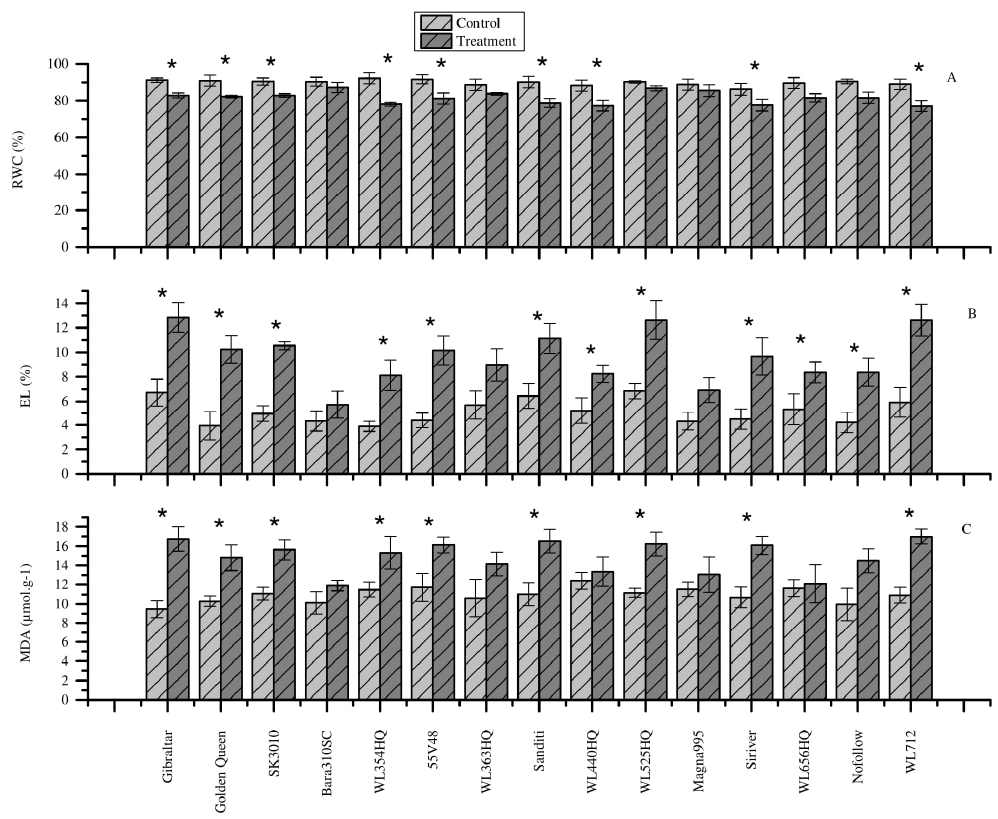
Figure 1. Effects of heat stress on physiological parameters. ( A ) Relative water content. ( B ) Electrolyte leakage. ( C ) MDA content. Each bar represents the mean ( n = 5) and the error bar indicates the standard deviation. Asterisks indicate statistically significant differences between control and treatment group for each cultivar ( p < 0.05), independent sample t-test. EL is electrolyte leakage, MDA is malondialdehyde.